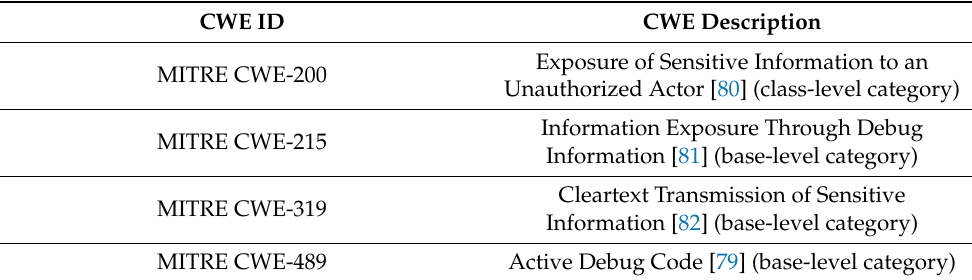
Table 5. MITRE CWEs related to sensitive data